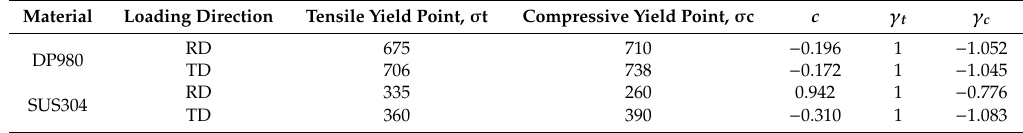
Table 1. Material parameters in uniaxial conditions.